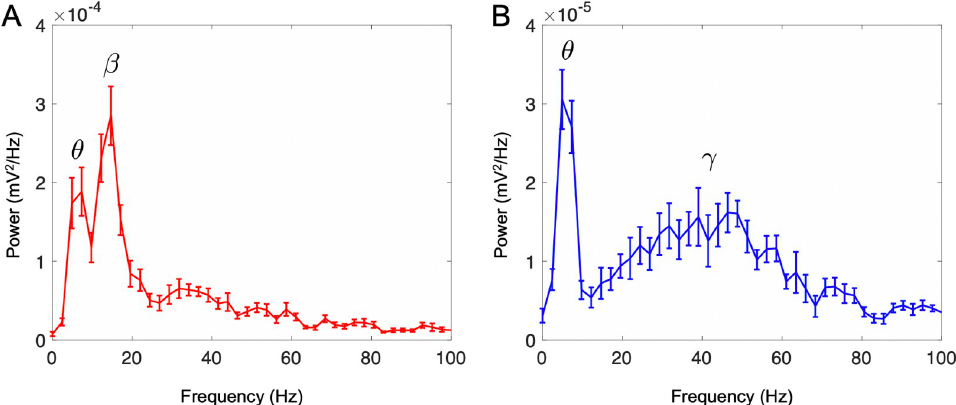
Fig 4. Oscillatory dynamics. (A) A network with a 15:1 GC:MC ratio. Odor input to a subset of glomeruli caused oscillations at * 15 Hz, in the lower beta range (15–40 Hz), in addition to activity at 6 Hz, corresponding to respiration in the theta range (2–12 Hz). (Bottom). (B) A network simulating tonically inhibited GCs, and hence a lower 5:1 active GC: MC ratio. Odor input caused oscillations with a broad frequency peak around 40–55 Hz, in the gamma range (35–100 Hz) as well as activity at 6 Hz, corresponding to respiration in the theta range. Curves averaged from 10 trials; bars indicate standard error.